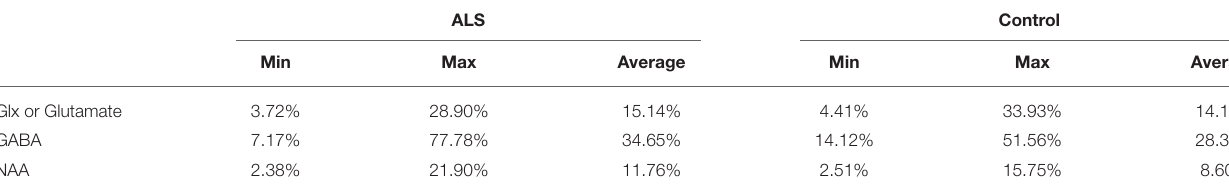
TABLE 5 | Coefficient of variation for all 1 H-MRS studies